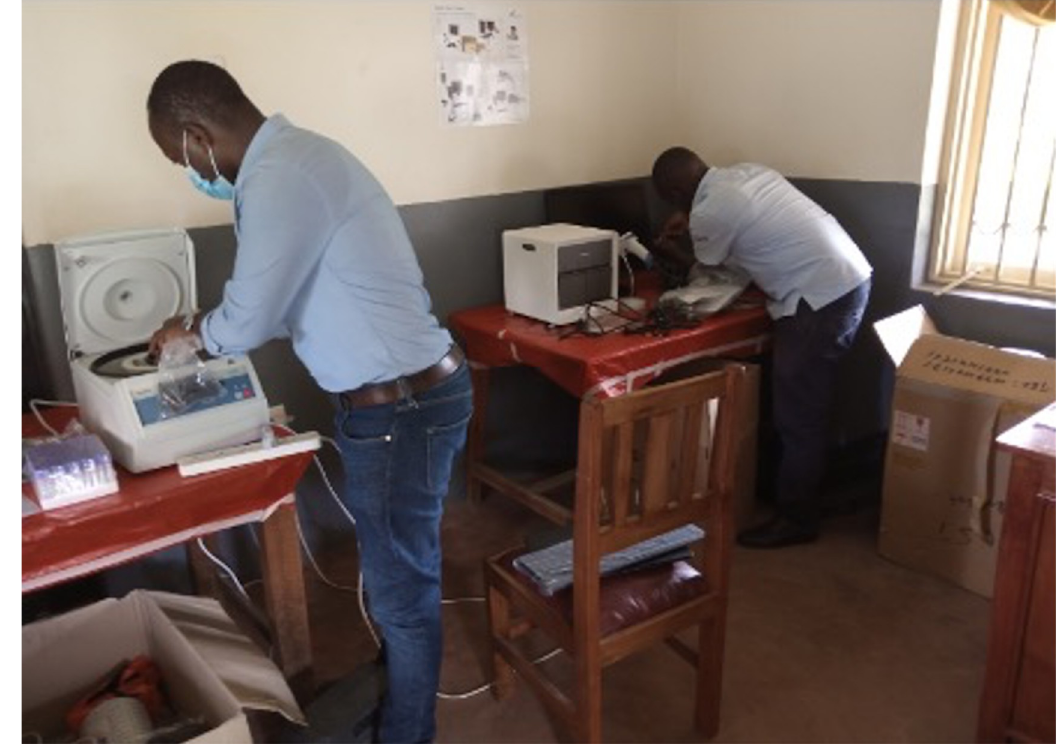
Fig 3. Installation of the GeneXpert platform at